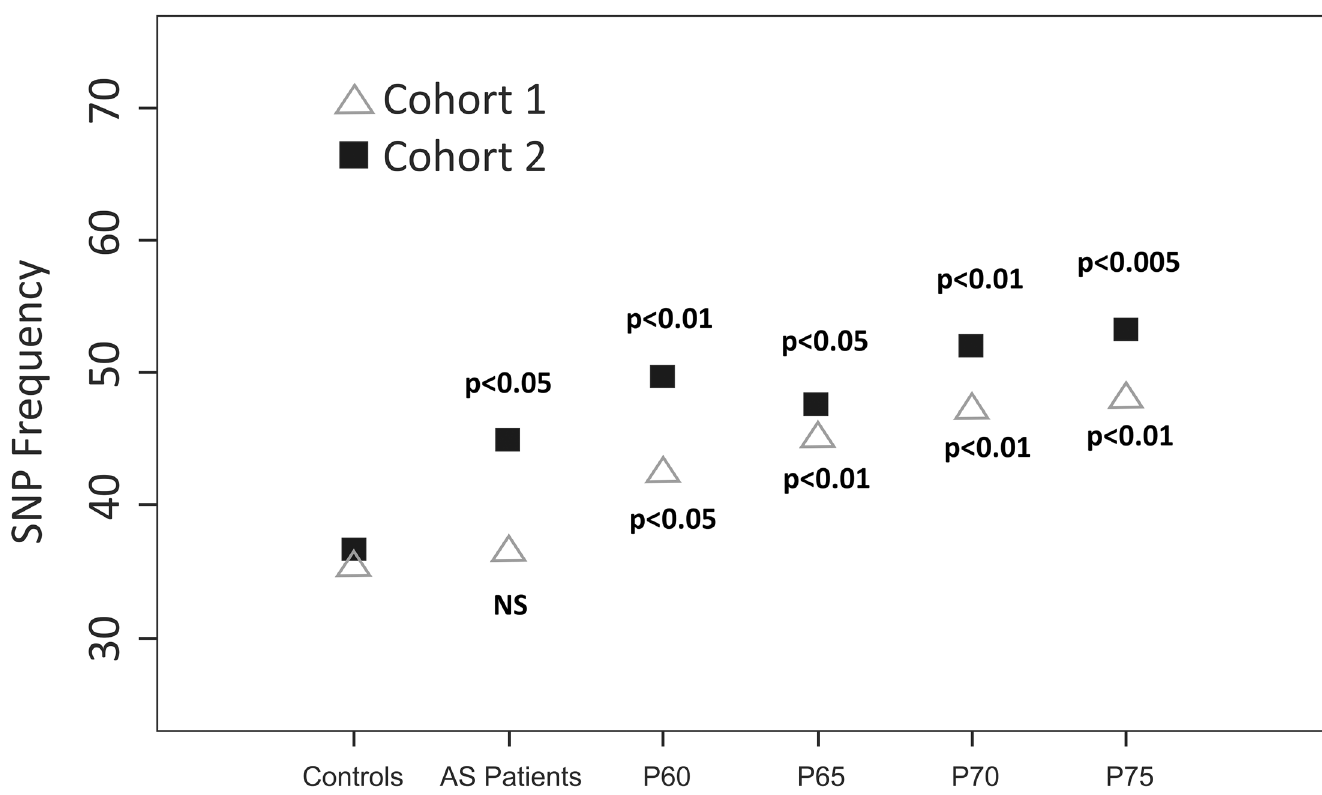
Fig 1. IL17RA rs4819554 genotype frequency (Gx) based on BASFI/t-duration. Note: Cohort 1. (BASFI/t p75 vs . controls: 48.0% vs . 35.3%, p < 0.01). R 2 = 65%. Cohort 2. (BASFI/t p75 vs . controls: 53.2% vs . 36.6%, p < 0.005) R 2 = 95%.